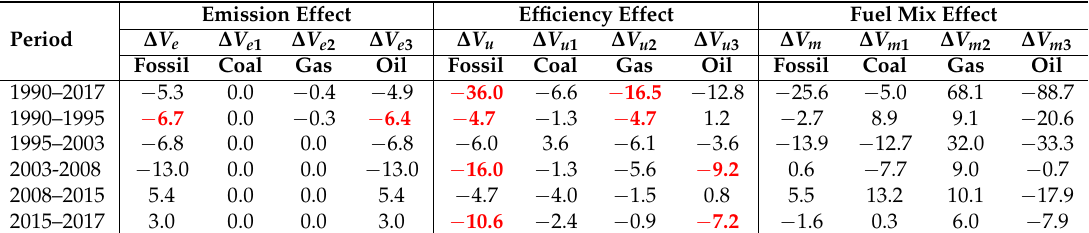
Table 3. The additive IDA-LMDI analysis results by fuel type in all periods (gCO 2